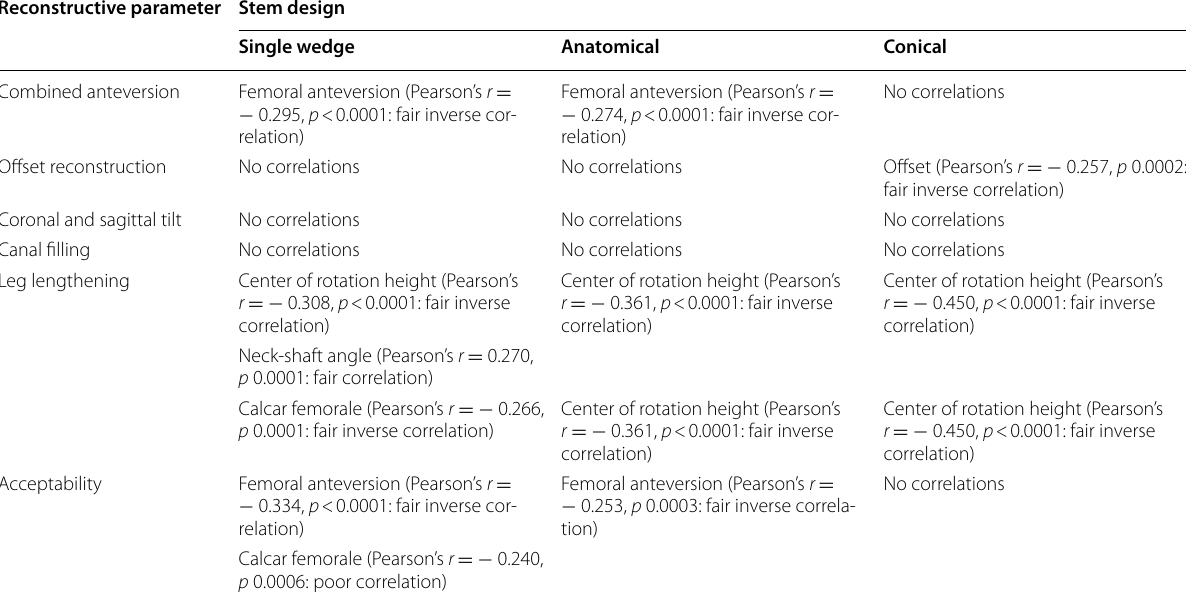
Table 3 The correlations between the reconstructive parameters and the native morphology for each stem design (only fair correlations are